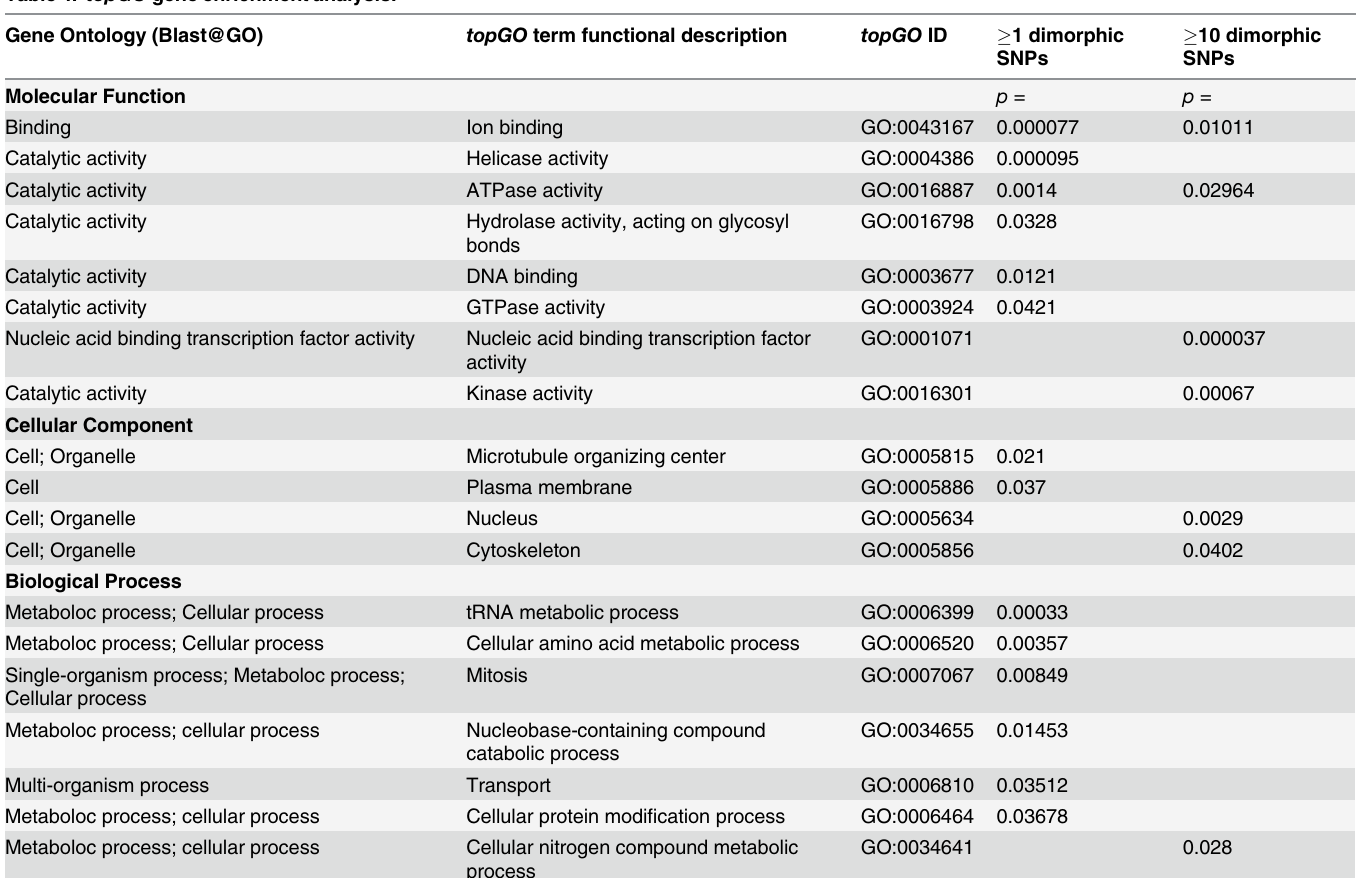
Table 4. topGO gene enrichment